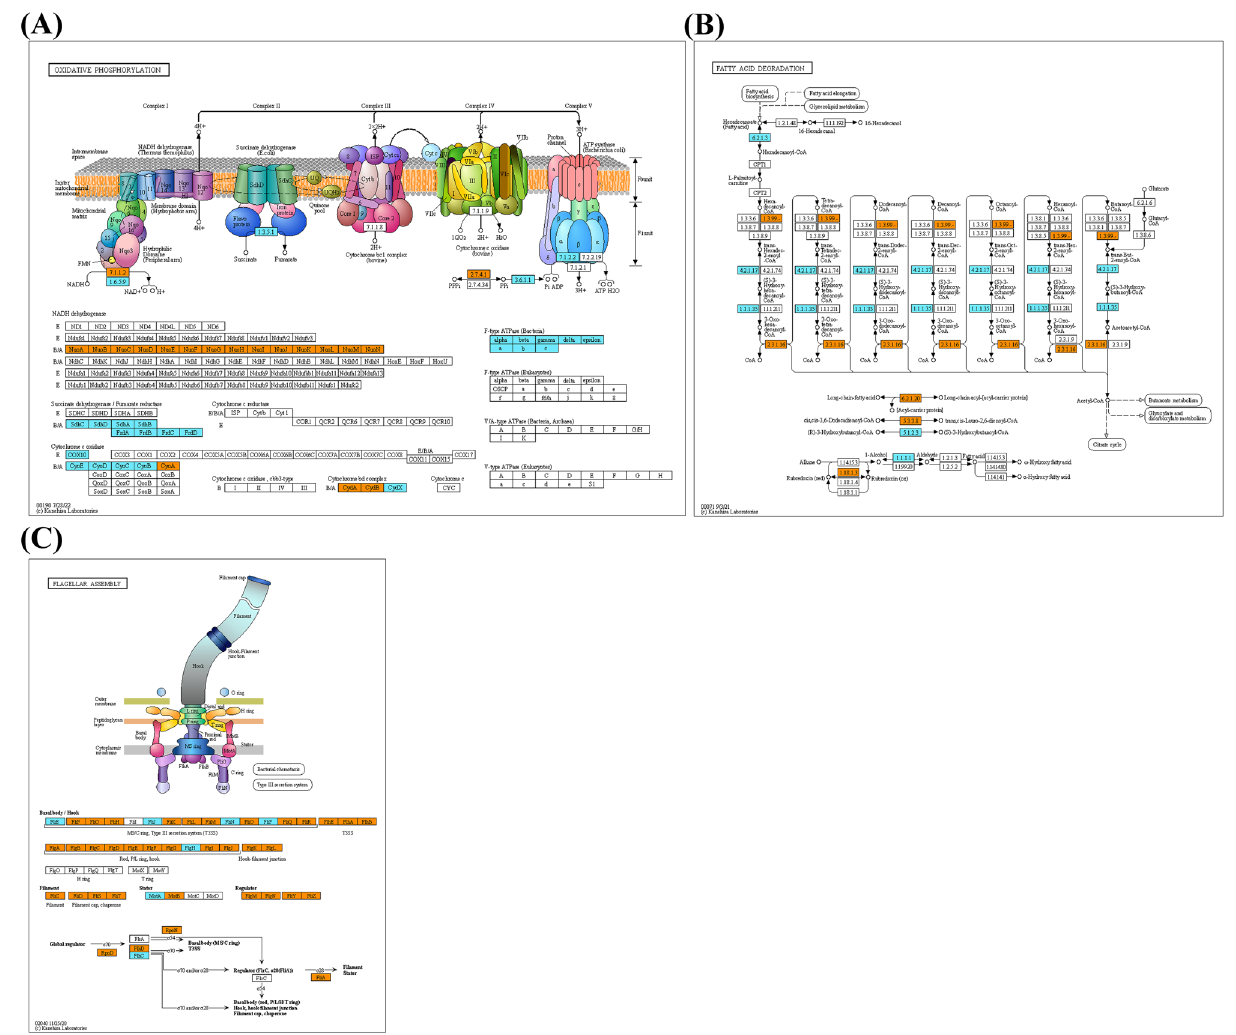
Figure 5. Down-regulated (blue) and up-regulated genes (Orange) of E. coli O157:H7 under the influence of blue (465 nm) illuminated light in comparison with the control in the pathway of oxidative phosphorylation ( A ), fatty acid degradation ( B ) and flagellar assembly ( C ). Pathway analysis of the selected genes was performed using the KEGG fructose and mannose, galactose, ascorbate and aldarate, and starch and sucrose metabolism genes were signifi- cantly down-regulated in E. coli O157:H7 grown under 465 nm illumination compared to 520 nm and 625 nm